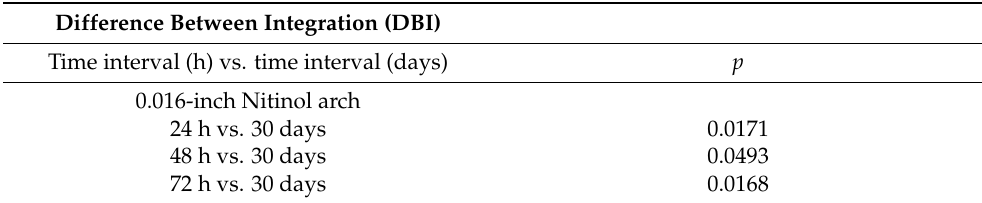
Table 4. A time interval comparison (hours and days) of the variable difference between integration in patients with orthodontic treatment. Difference Between Integration (DBI) Time interval (h) vs. time interval